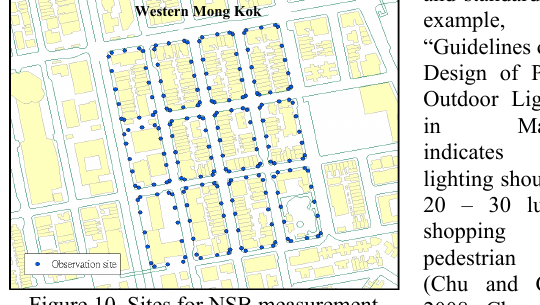
Figure 10. Sites for NSB measurement